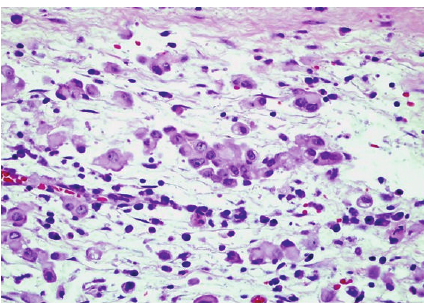
Figure 2: Mesothelioma (H&E, high